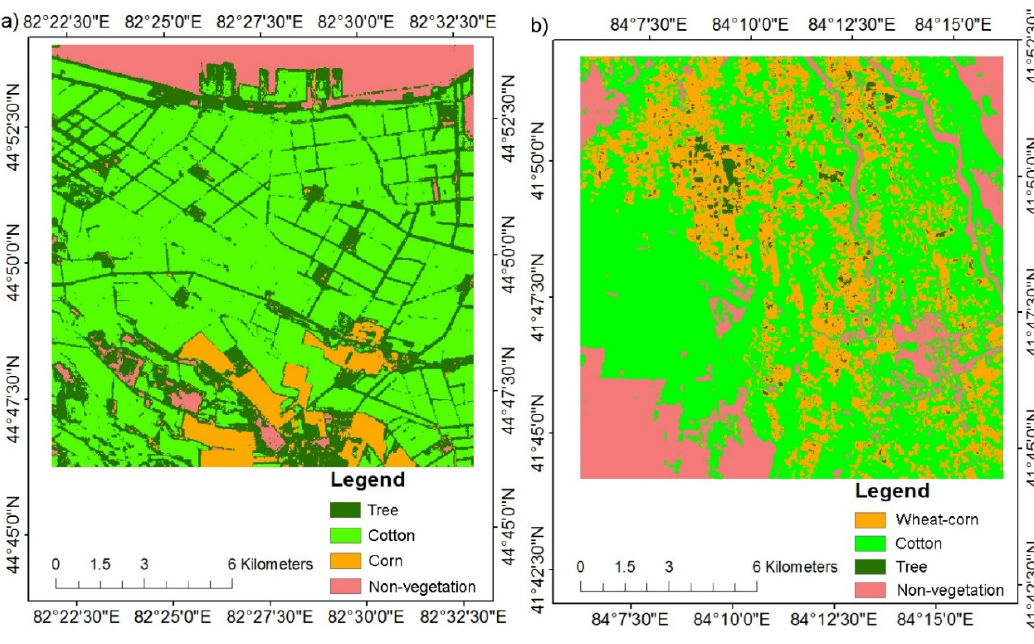
Figure 8. Land cover types in ( a ) Bole and ( b ) Luntai. Table 8. Accuracy evaluations of (1) Luntai and (2) Bole.